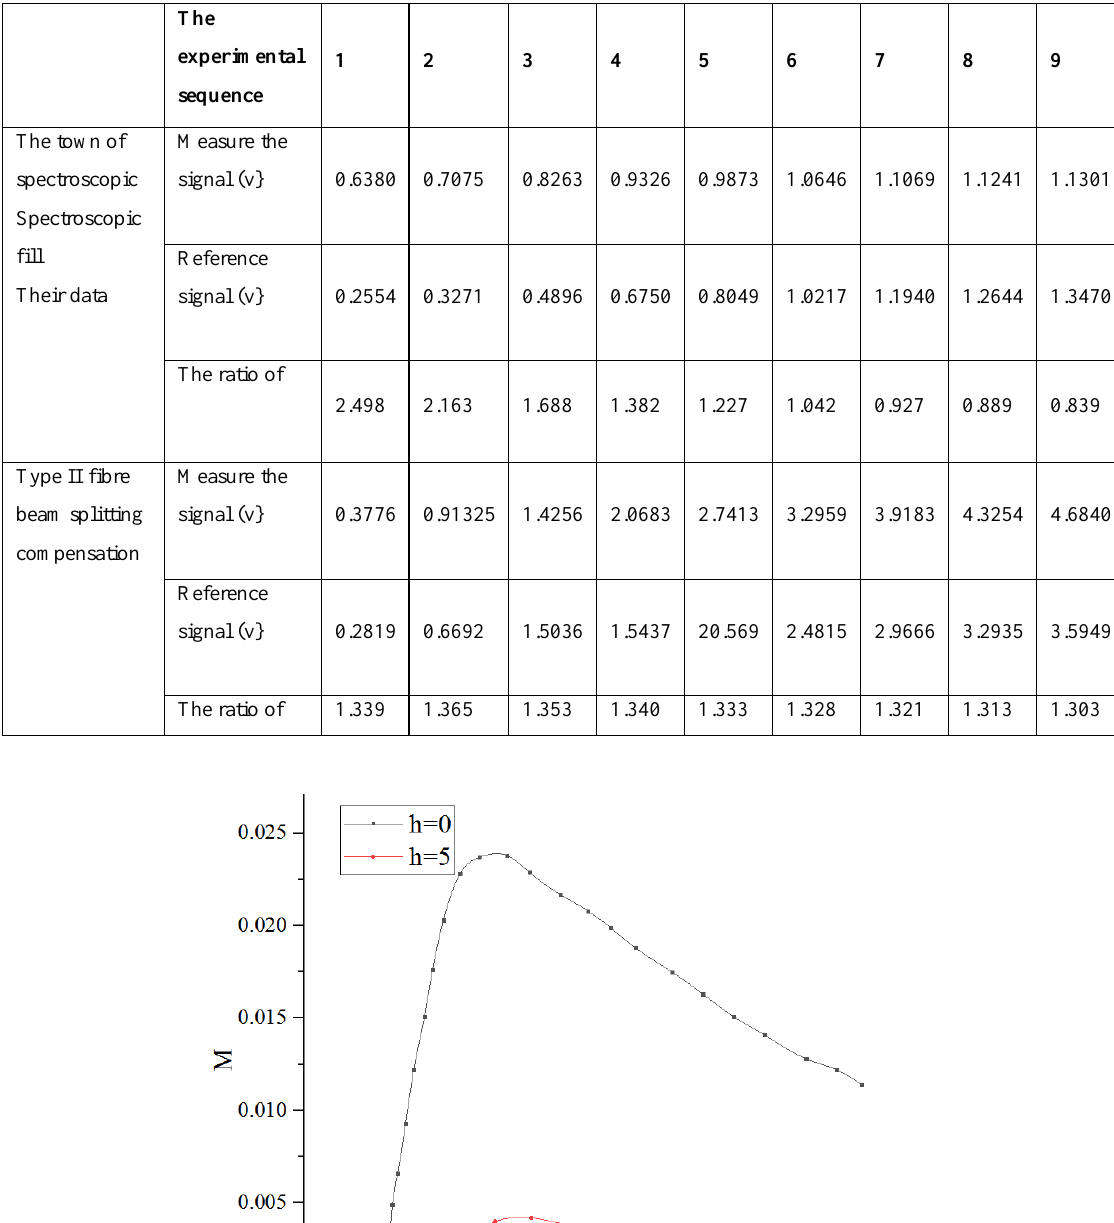
Table 1 Experimental data of two kinds of spectral compensation